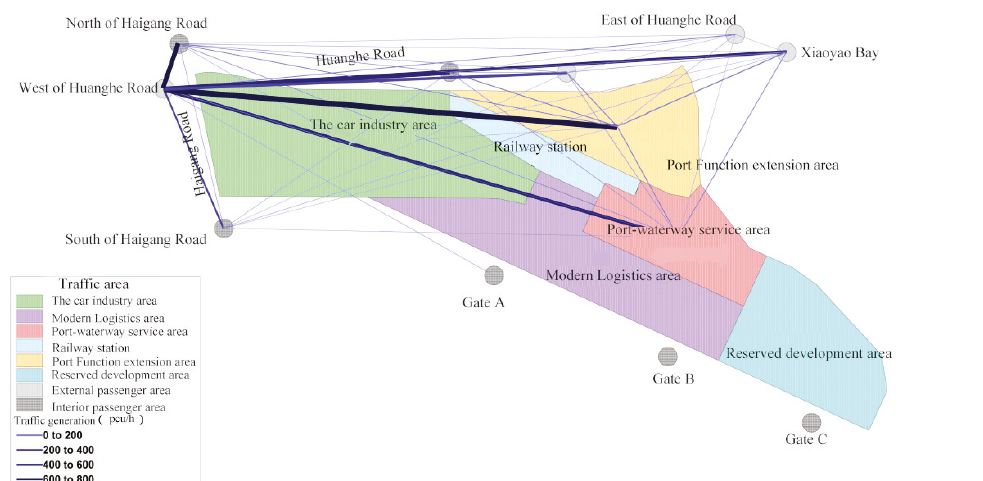
Figure 16: The travel forecasting of motor vehicles in 2015.